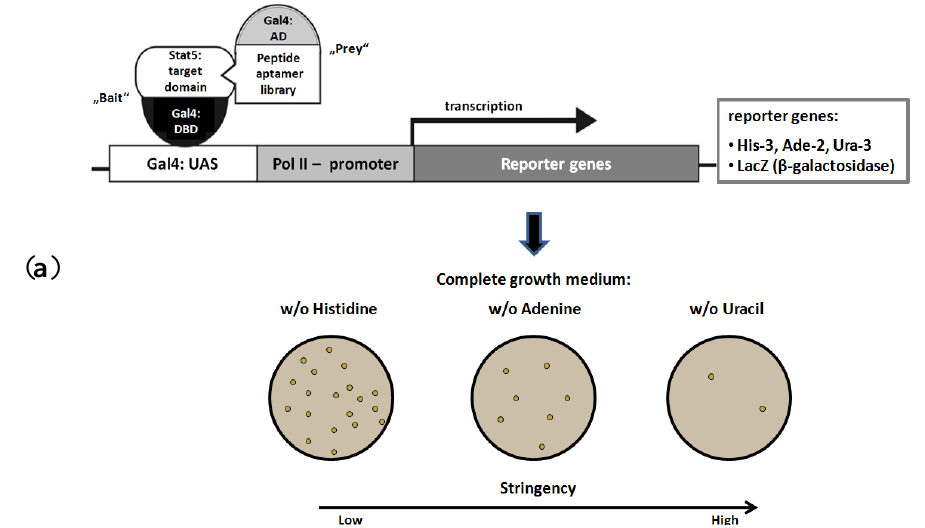
Figure 2. Identification of a 12mer peptide aptamer sequence (S5-DBD-PA) that specifically binds with high affinity to the DNA-binding domain (DBD) of Stat5. ( a ) Yeast-two-hybrid (Y2H) screening strategy for the isolation of PA sequences that interact with a functional domain of human Stat5. Y2H screens were performed with a yeast strain (KF1) containing four different Gal4-dependent reporter genes of different stringency. This included genes for the biosynthesis of histidine ( His-3 ), adenine ( Ade-2 ) and uracil ( Ura-3 ) as well as the LacZ -reporter gene for β-galactosidase expression and activity measurement. The corresponding expression vectors (bait and prey) were co-transformed into yeast cells, which were plated and grown under highly stringent conditions on selective media lacking uracil, for identifying the strongest PA interactions. The clone with the best binding properties after revalidation was chosen for further analysis. ( b ) Schematic representation of the cloned bait and prey fusion proteins used for Y2H screening. The DBD of human Stat5A comprises amino acids 331 to 473, indicated in red in the crystallographic structure of a Stat-dimer bound to DNA [47]. This domain was fused to the Gal4 DNA-binding domain (Gal4-DBD) and used as bait. The complex 12-mer PA library was expressed within the active loop of the modified human thioredoxin scaffold (hTRX Δcys5 , schematically indicated by the hTRX crystal structure), which was fused to the Gal4 transcriptional activation domain (Gal4-AD). These random PA sequences presenting fusion proteins were used as prey constructs. ( c ) The specificity of binding of the identified aptamer (S5-DBD-PA) to the STAT5-DBD was verified after plasmid sequencing and retransformation by plating the yeast cultures in 1:10, 1:100 and 1:1,000 dilutions on selective media lacking leucine (L) and tryptophan (T), which synthesis genes were encoded by the corresponding bait and prey expression vectors, and additionally either histidine (H), adenine (A) or uracil (U). Weak interactions allow growth on -LTH, whereas growth on -LTU requires strong interactions. The interaction of p53 or lamin C with the SV40 Large T antigen served as positive and negative controls. The Gal4-AD (GAD) fused S5-DBD-PA binding properties against the single GAL4-DBD (GBD) and other fused domains of Stat3 and Stat5 (DBD- or SH2-domain) were additionally evaluated. Protein interactions were also quantified by measuring β-galactosidase activity. Results are shown as Miller-Units (n = 3; Ø ± SD).